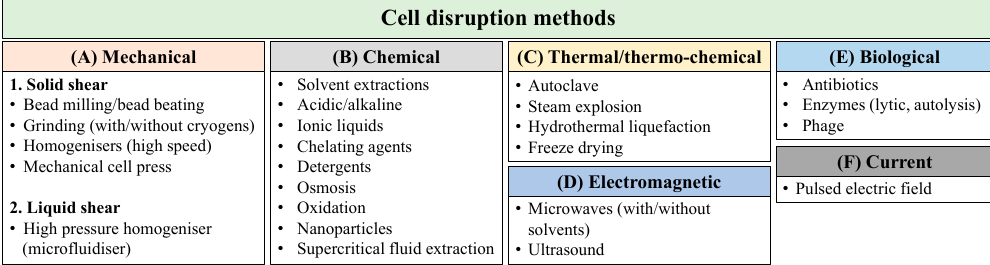
Figure 1. Summary of cell disruption methods used for microalgae.